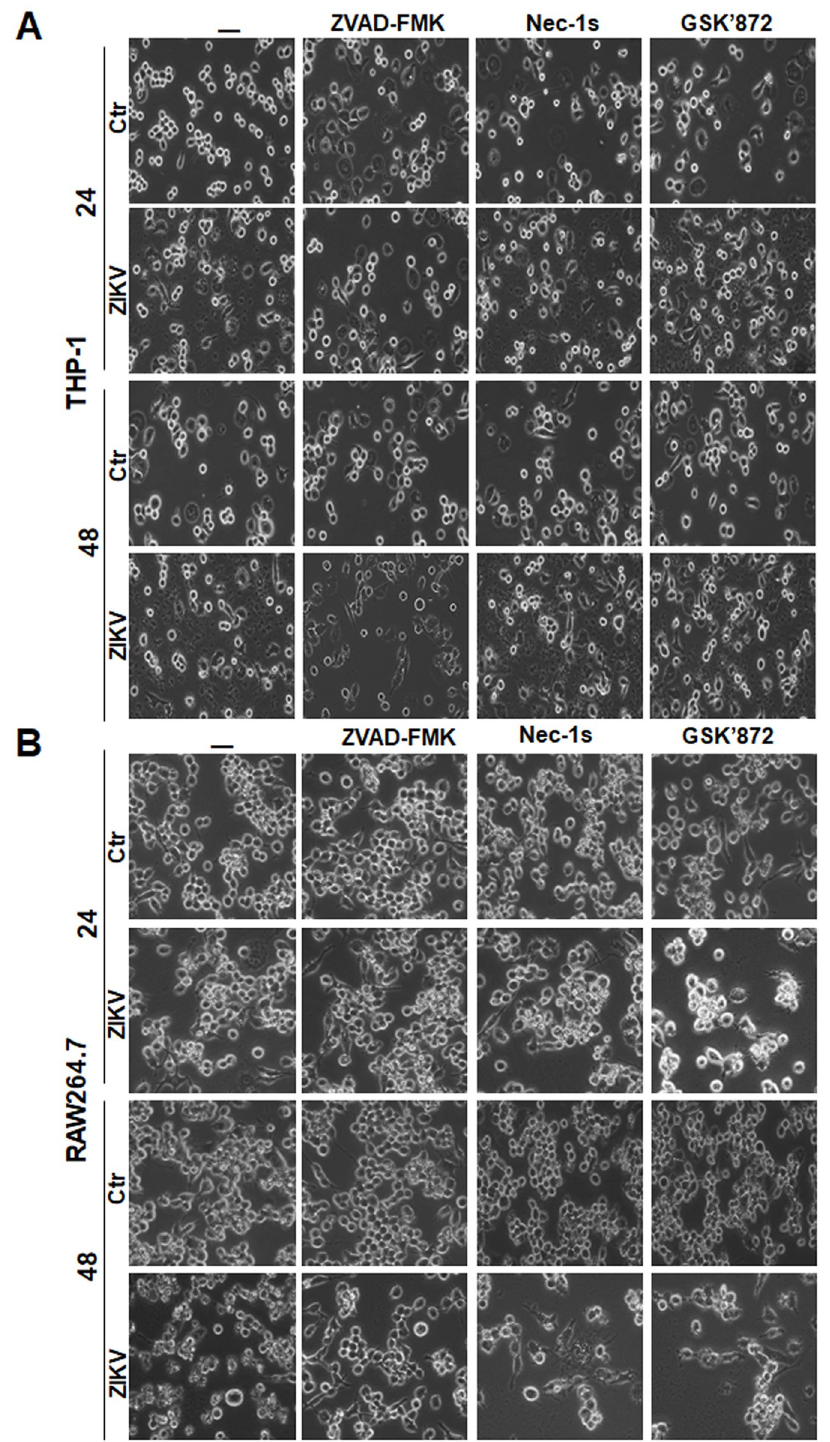
Fig 2. Morphological changes of cell death induced in ZIKV-infected monocytes pre-treated by programmed death inhibitors. THP-1 ( A ) and RAW264.7 ( B ) cells were pre-treated with pan-caspases inhibitor, ZVAD-FMK, or RIPK inhibitors, Nec-1s and GSK’872, followed by infection with ZIKV at 0.1 MOI. The cells were observed at 24 and 48 hrs p.i. under a light microscope (Magnification x200).